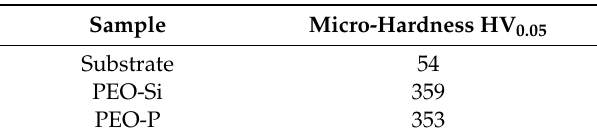
Table 5. Results of micro-hardness